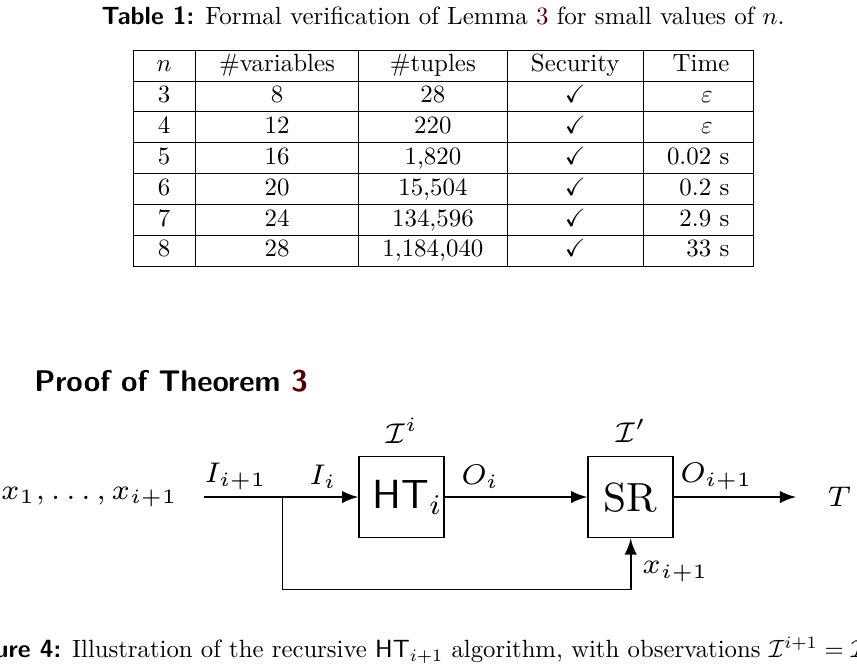
Figure 4: Illustration of the recursive HT i +1 algorithm, with observations I i +1 = I i ∪ I 0